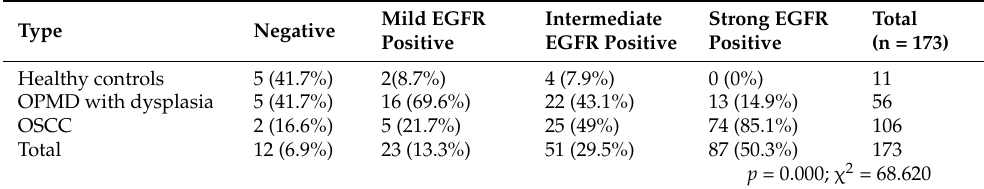
Table 2. Clinical histopathological features in EGFR-positive groups in healthy controls and OSMF and OSCC patients.